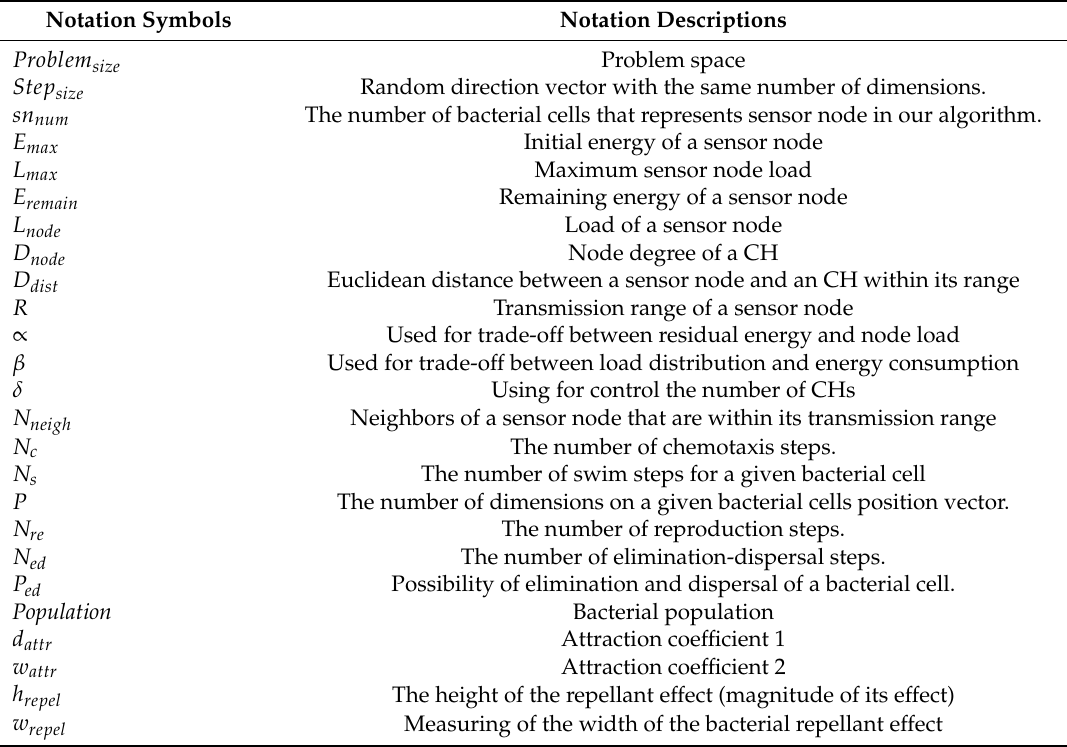
Table 2. The some notations used in the